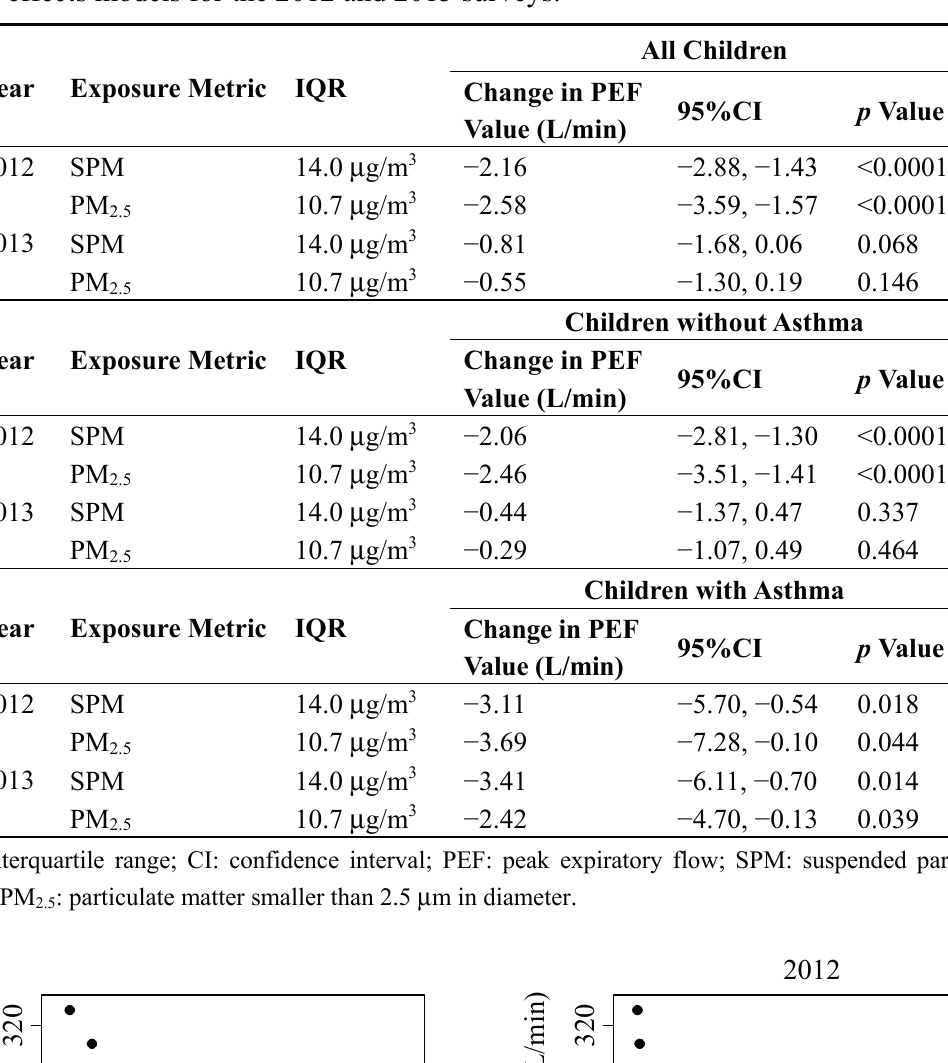
Table 2. Associations of PEF values with interquartile increases in SPM and PM 2.5 in linear mixed-effects models for the 2012 and 2013